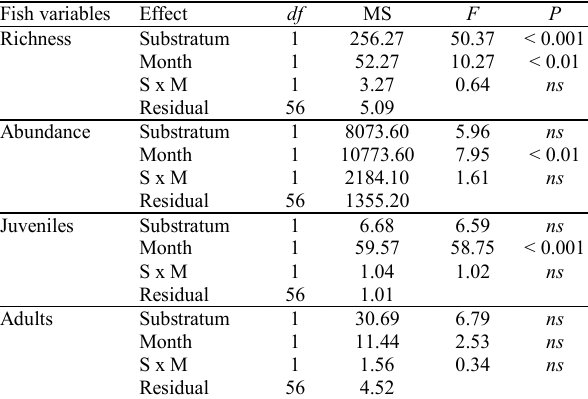
Fig. 2. Mean values (±SE) of temporal fluctuation and temporal